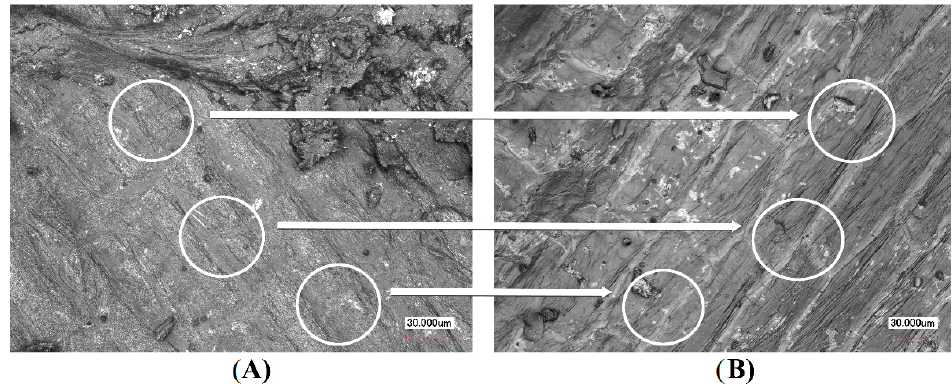
Figure 2. Morphology of surface: ( A )—rice husk; ( B )—biochar.